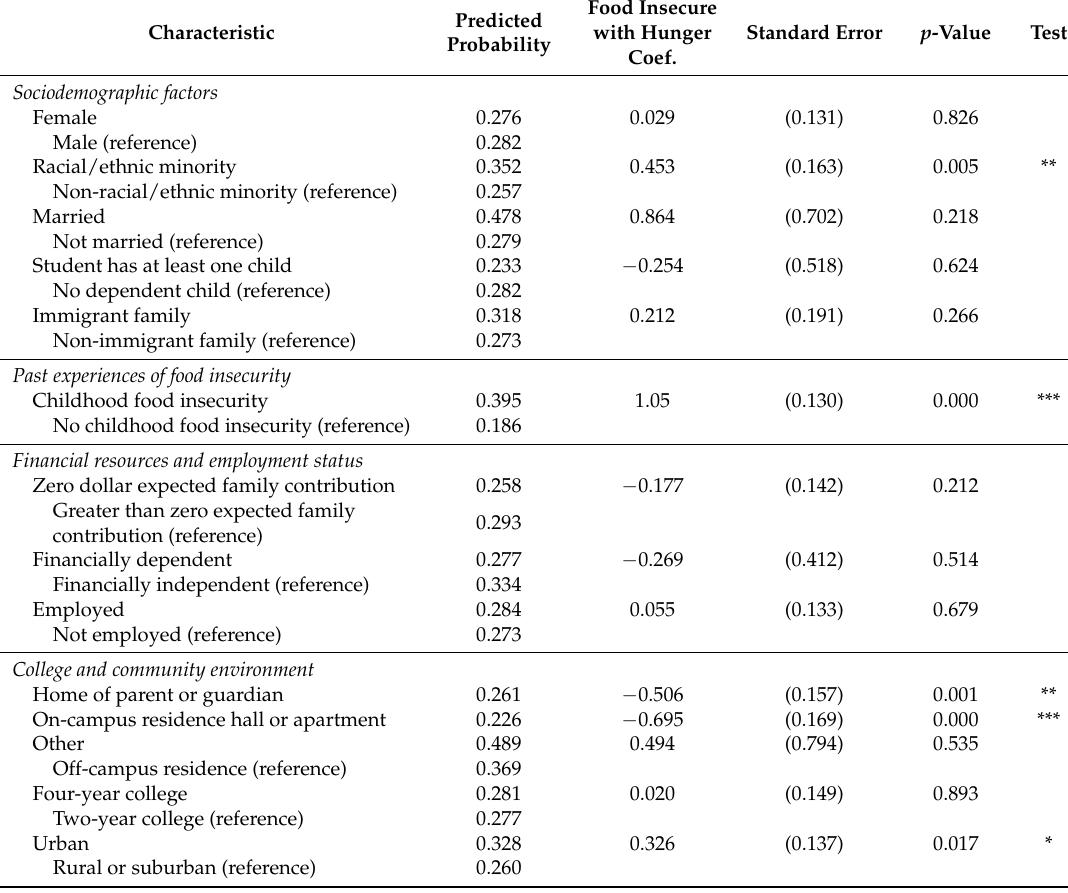
Table 3. Predicting food insecurity using logistic